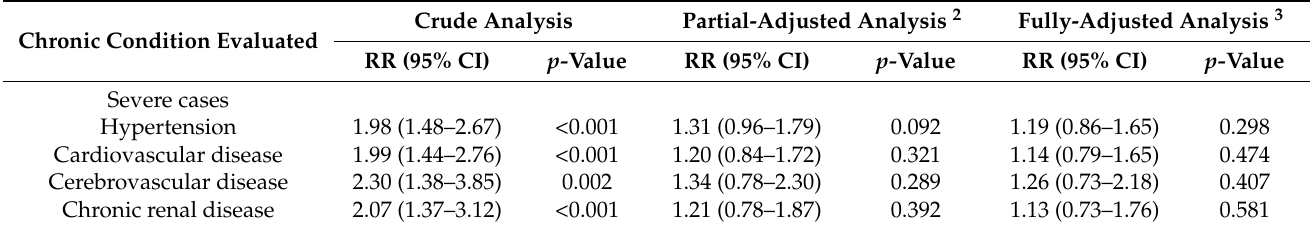
Table 5. Effect of hypertension and hypertension-related conditions on severe outcomes 1 among patients hospitalized for